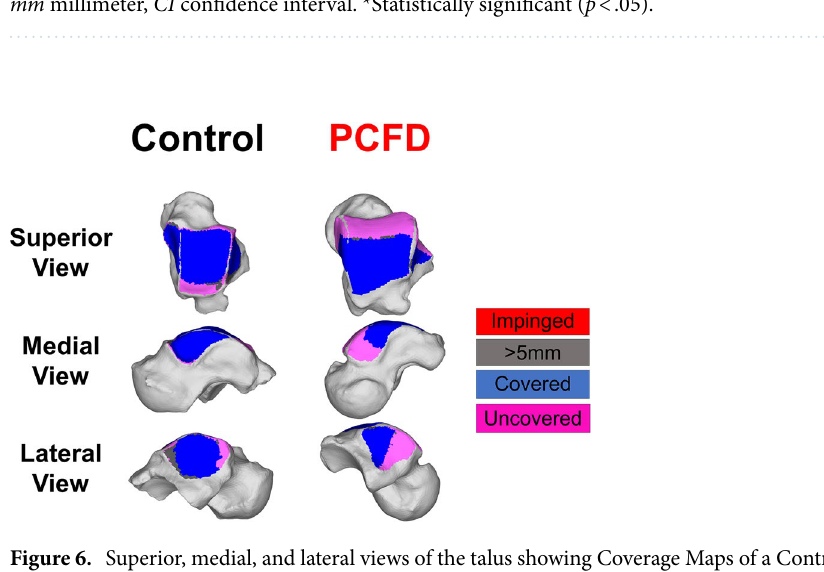
Table 4. Means and Standard Deviations for Tibiotalar and Talofibular Articular Distances Measured in Millimeters, and Mean Difference in Distances from Control to Progressive Collapsing Foot Deformity Patients with P Values and 95% Confidence Intervals for Comparisons. Bolded rows denote significant changes within the region. PCFD progressive collapsing foot deformity, MD mean difference, SD standard deviation, mm millimeter, CI confidence interval. *Statistically significant ( p < .05).